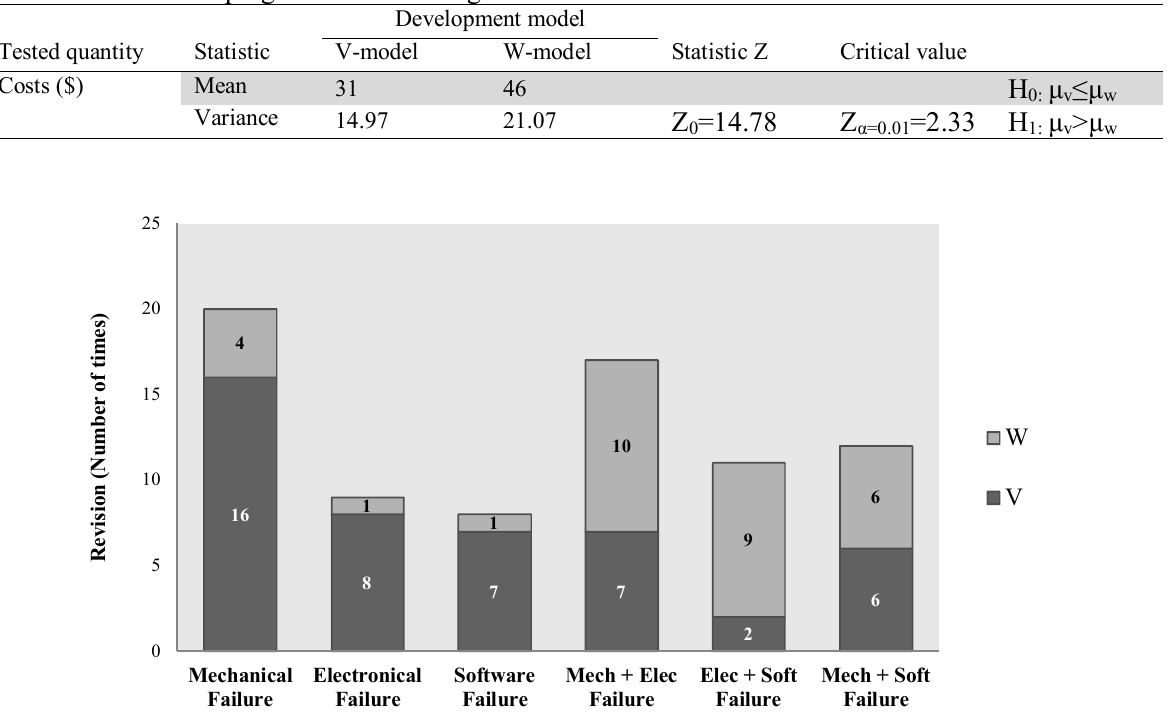
Fig. 11. Change in distribution revisions for design using V-model and